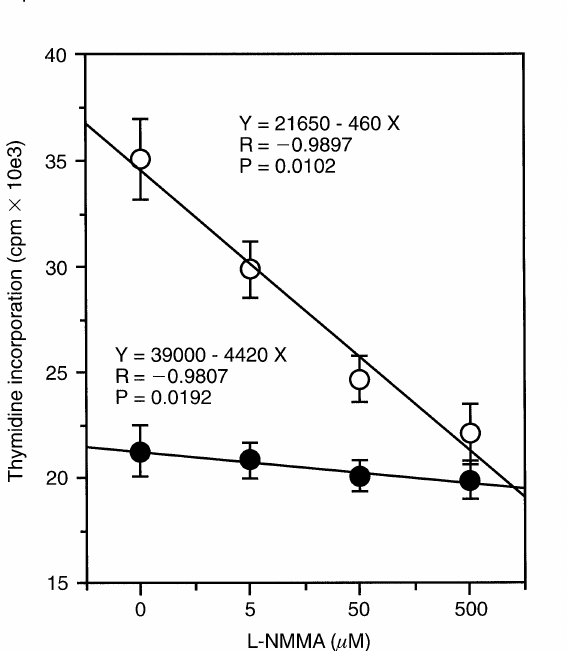
FIG. 1. Proliferation profile of CTLL-2 cells after 24h of cultures in responses to different concentrations of IL2, in absence (open circles) or presence (solid circles) of LNMMA at 500 #M. Each point is the mean-t-SEM of three experi- ments. Equation of the linear regression curve is also expressed on each case.